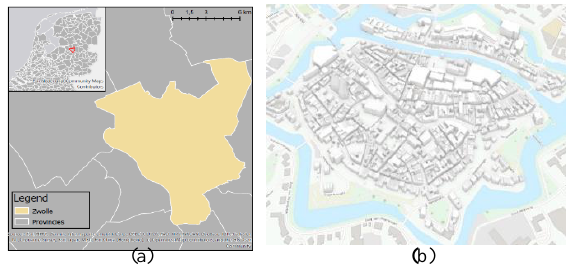
Figure 1. Study area of this research: (a) city of Zwolle in province Overijssel, the Netherlands and (b) subset of the study area in the 3D building